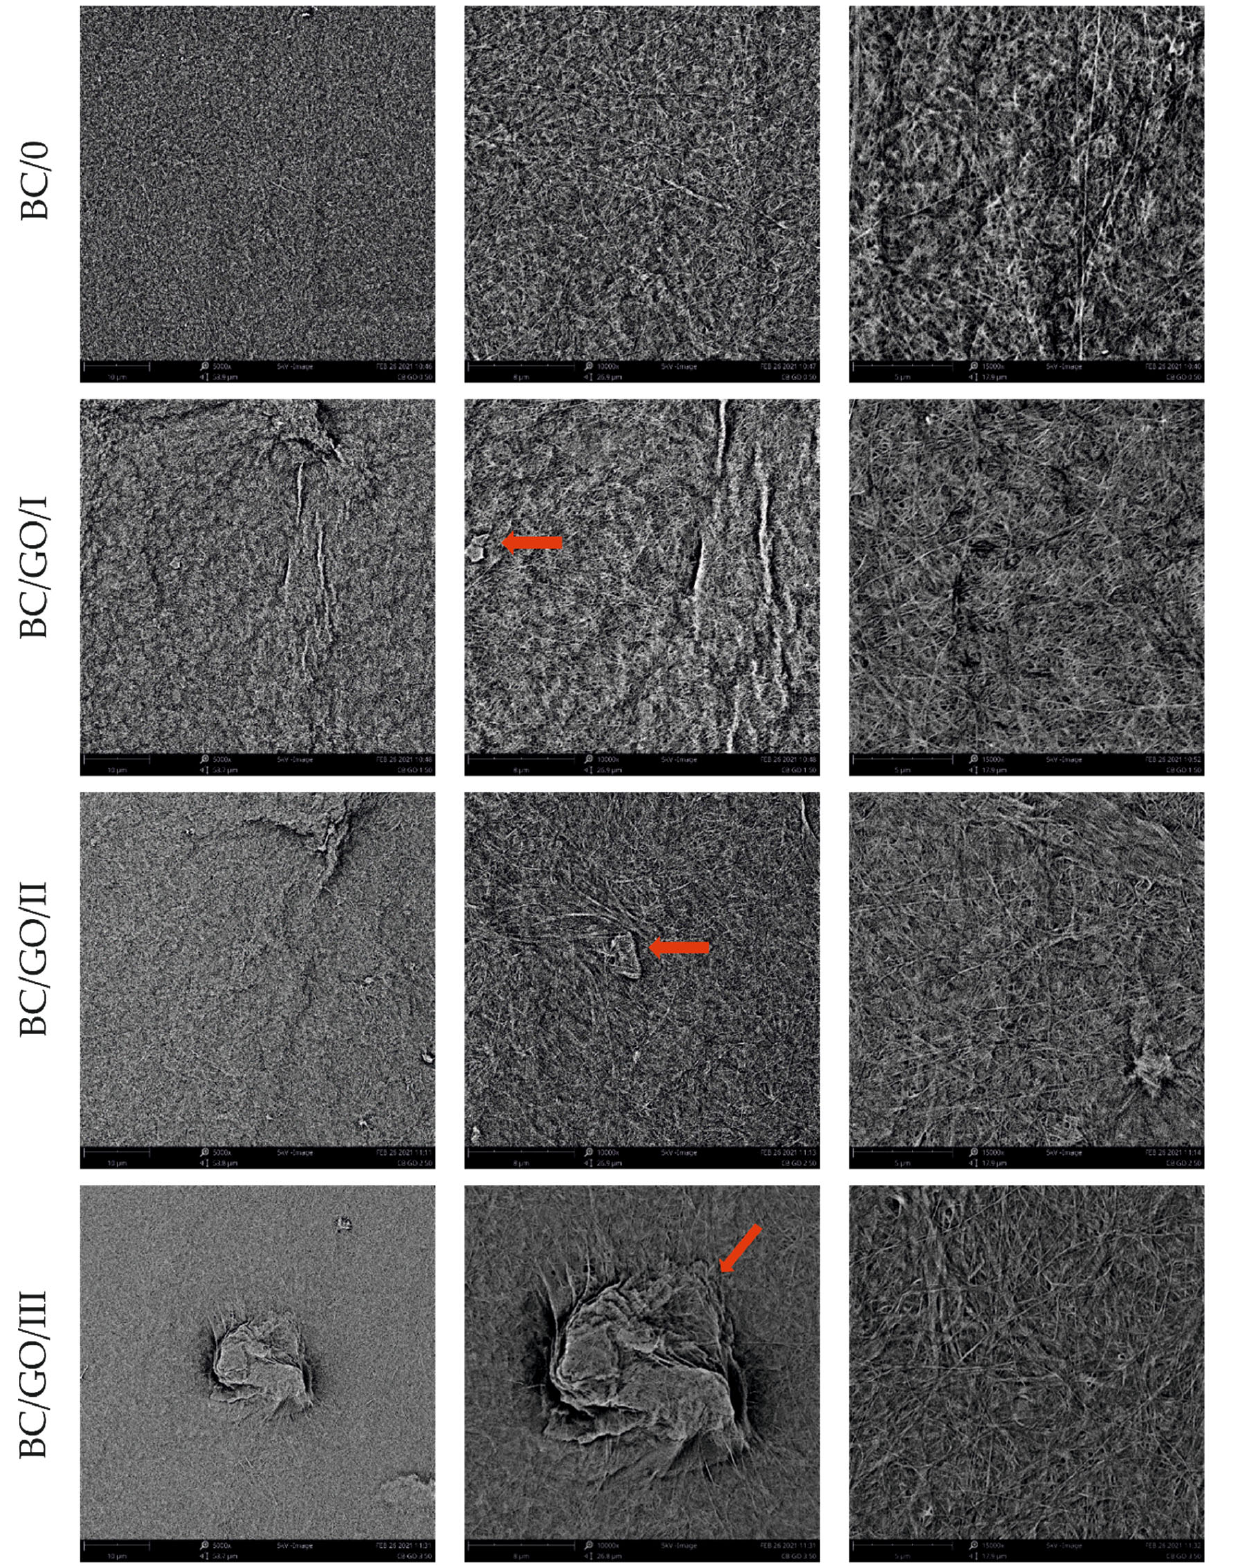
Figure 6. SEM pictures of the surface of BC (BC/0) samples and BC/GO/I, BC/GO/II, BC/GO/III composites at a magnification of 5000 × , 10,000 × , 15,000 ×.